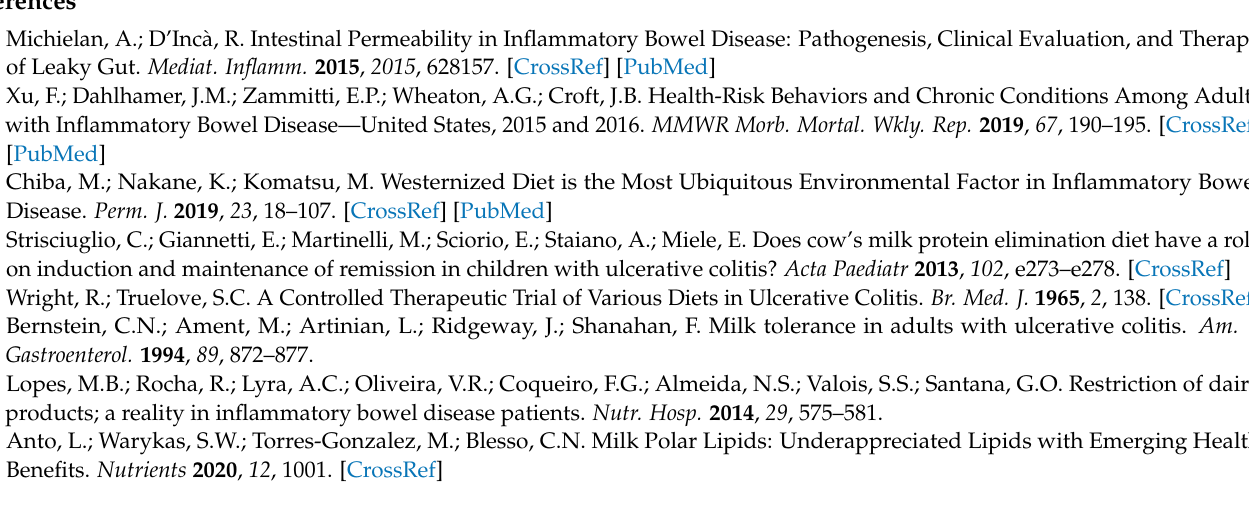
Colon RNAseq DEG Results; Table S3: Lipid Classes Lipidomics ANOVA; Table S4: Species Specific Lipidomics